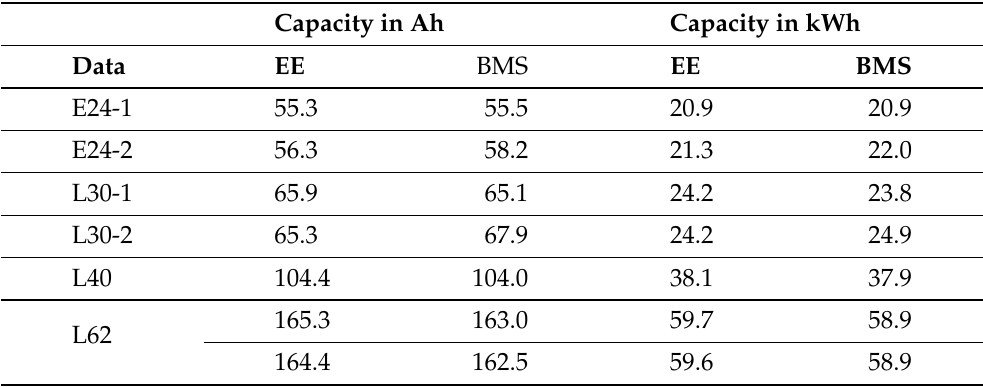
Table 6. Comparison of capacity derived with the ECE method with EE and BMS datasets in Ah and in